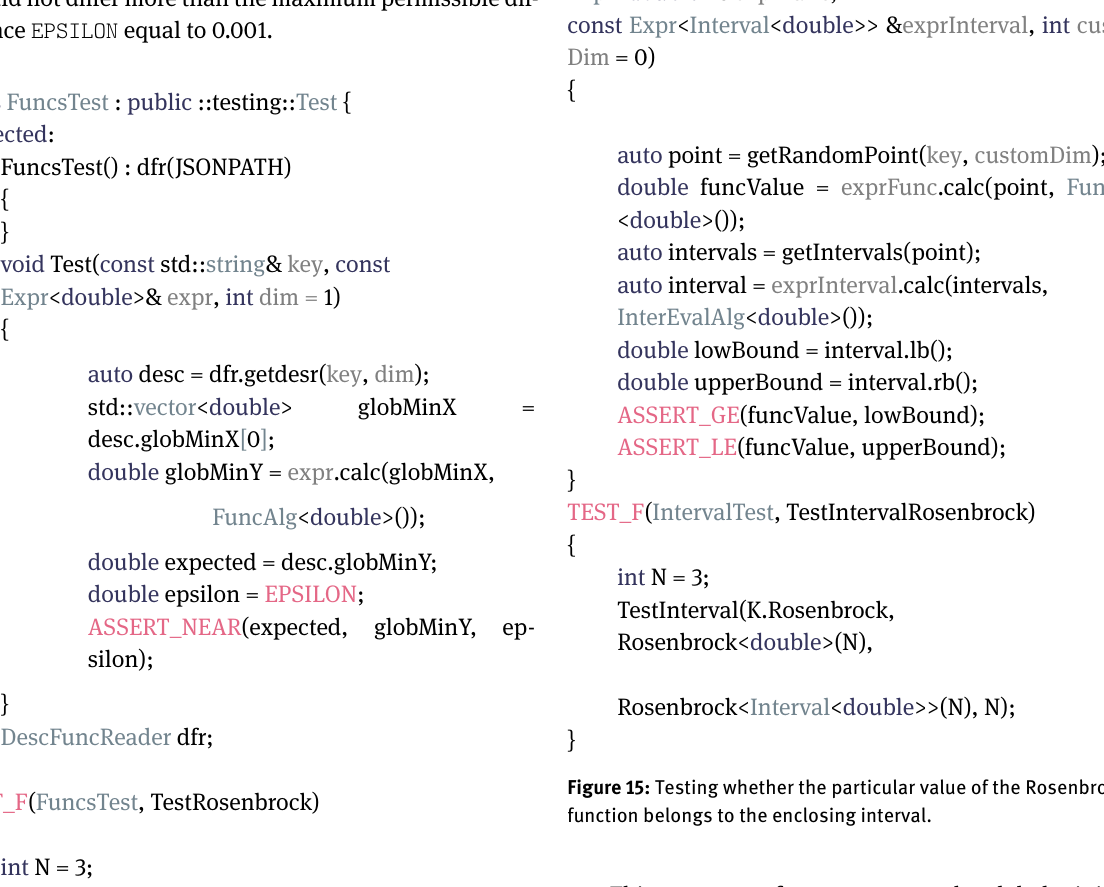
Figure 15: Testing whether the particular value of the Rosenbrock function belongs to the enclosing